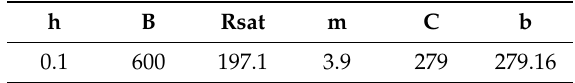
Figure 6. Clamped specimen with fixture.